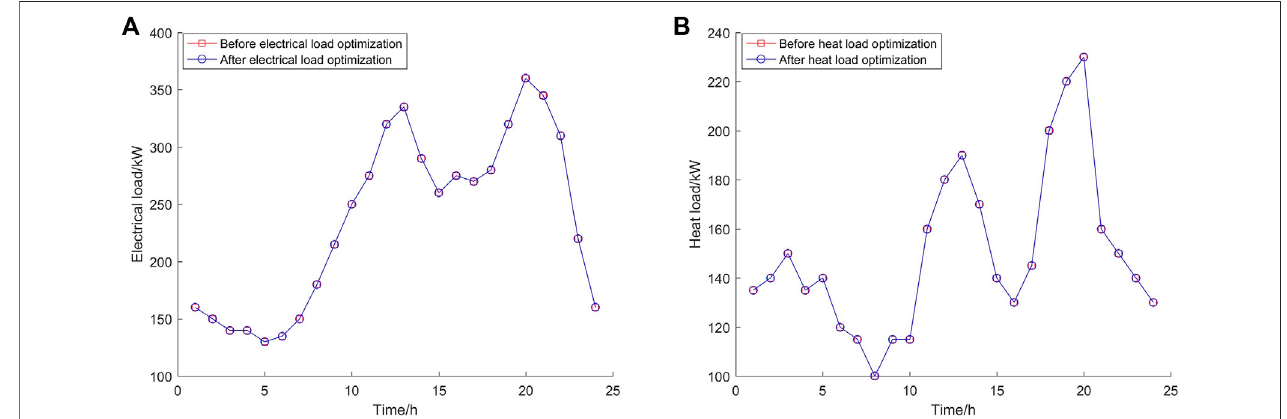
FIGURE11 | Scenario 2:Electricheatingload response curve before and after optimal scheduling. (A) Beforeoptimal scheduling and (B) after optimal scheduling.